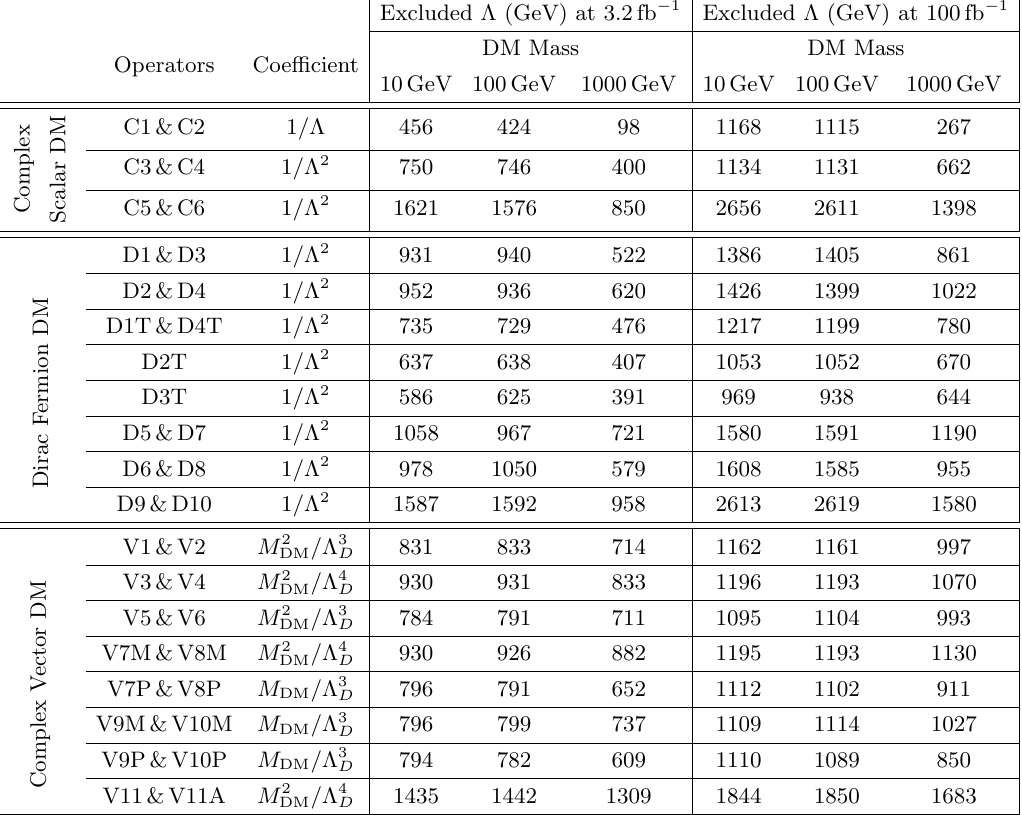
Table 5 . Projections for the exclusion limits for (cid:3) with a luminosity of 100 fb (cid:0) 1 with the cuts of the ATLAS search of ref.